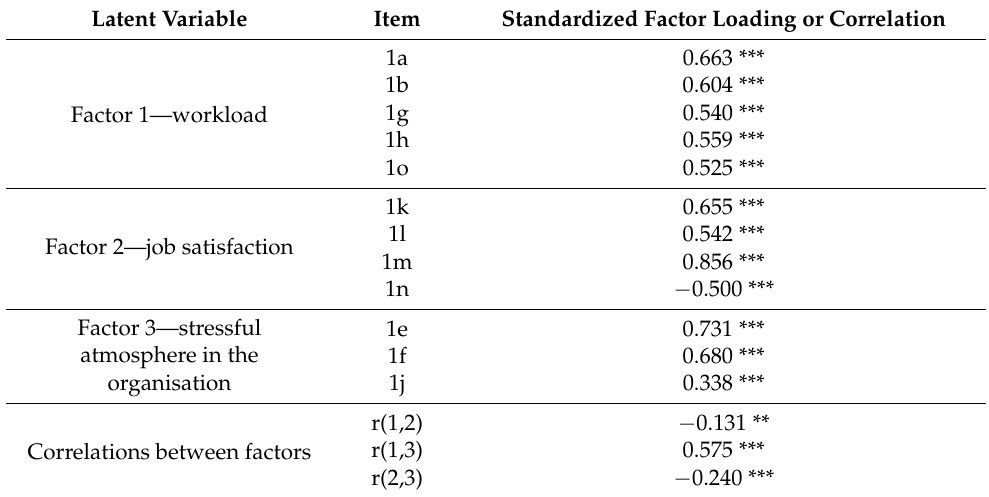
Table 5. Three-factor confirmatory factor analysis (CFA) model: parameter estimates and significance. Latent Variable Item Standardized Factor Loading or